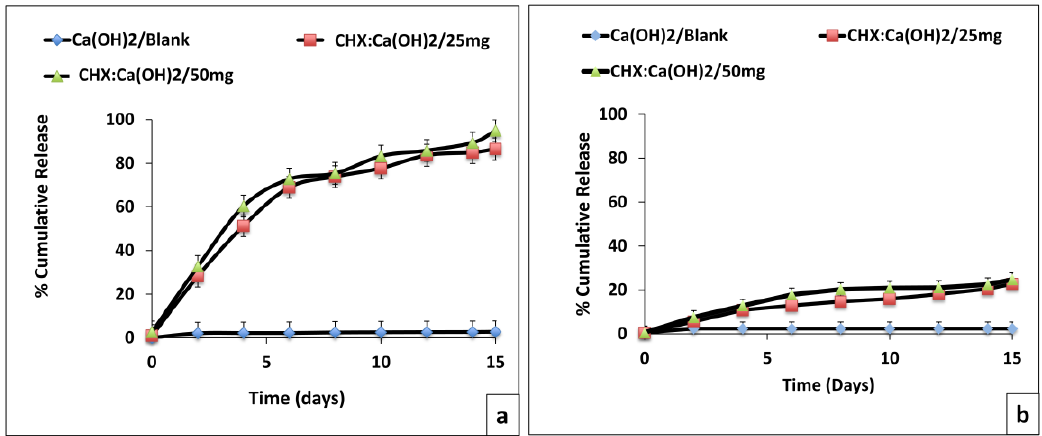
Figure 9. ( a ) The percentage (%) of cumulative CHX in vitro release from the CHX-loaded/Ca(OH) 2 microparticles at 37 °C in phosphate buffered saline (PBS) at the physiological pH of 7.4 up to 15 days (in-vitro release-profile). ( b ) The percentage (%) of cumulative CHX ex vivo release from the CHX-loaded/Ca(OH) 2 microparticles delivered to the dentin-substrate (ex-vivo release-profile) in phosphate buffered saline (PBS) at 37 °C at the physiological pH of 7.4 up to 15 days. Note: Statistical analysis of CHX-release was done with one-way ANOVA followed by Tukey-Kramer post-hoc test ( p ≤ 0.05; significant). The Ca(OH) 2 /Blank microparticles were used as control.